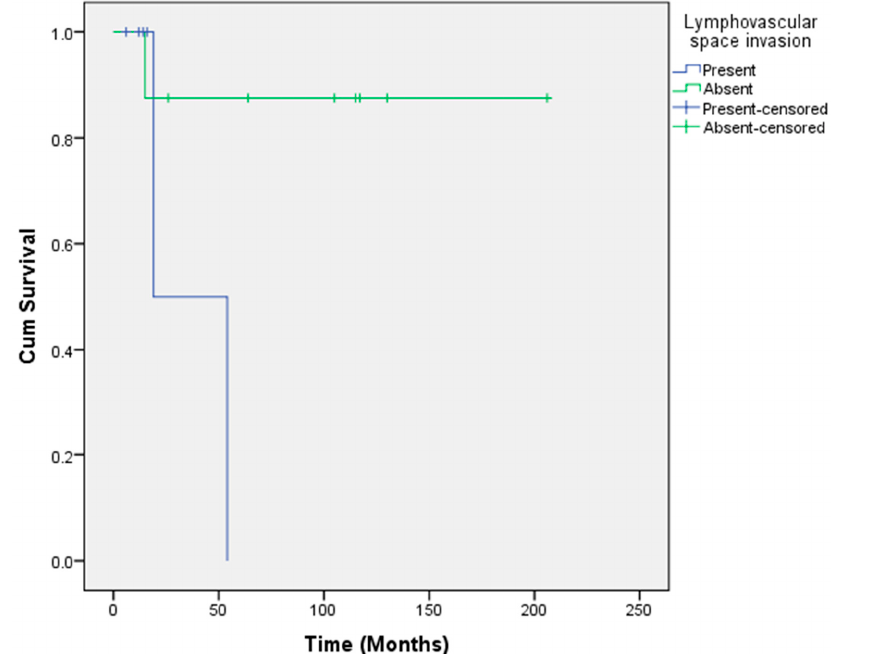
invasion was 36.5 months compared to 182.1 months when lymphovascular space invasion was absent ( p = 0.05) (Figure 1).